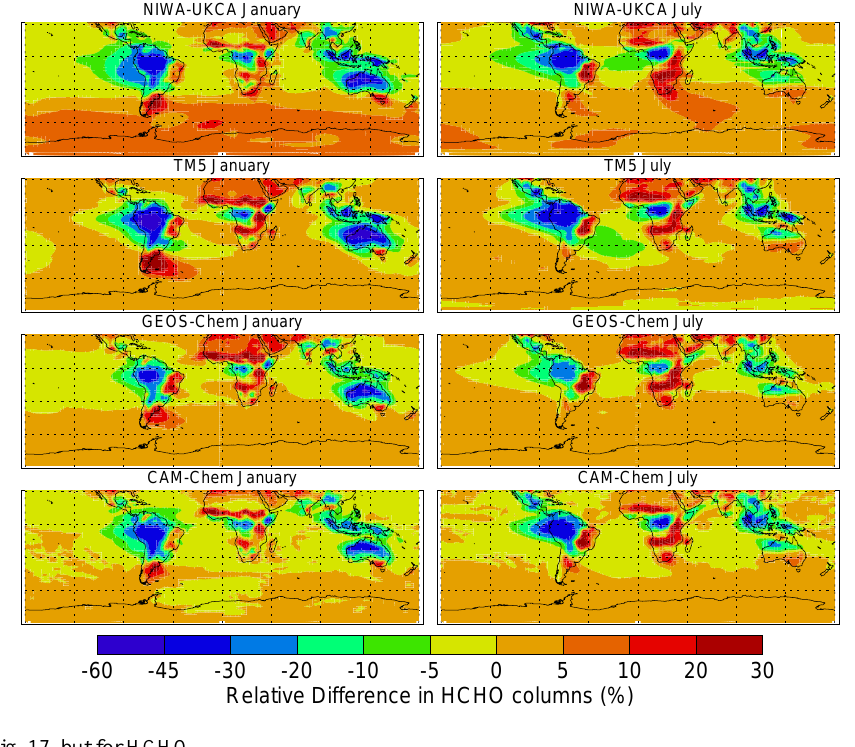
Figure 18. Same as Fig. 17, but for